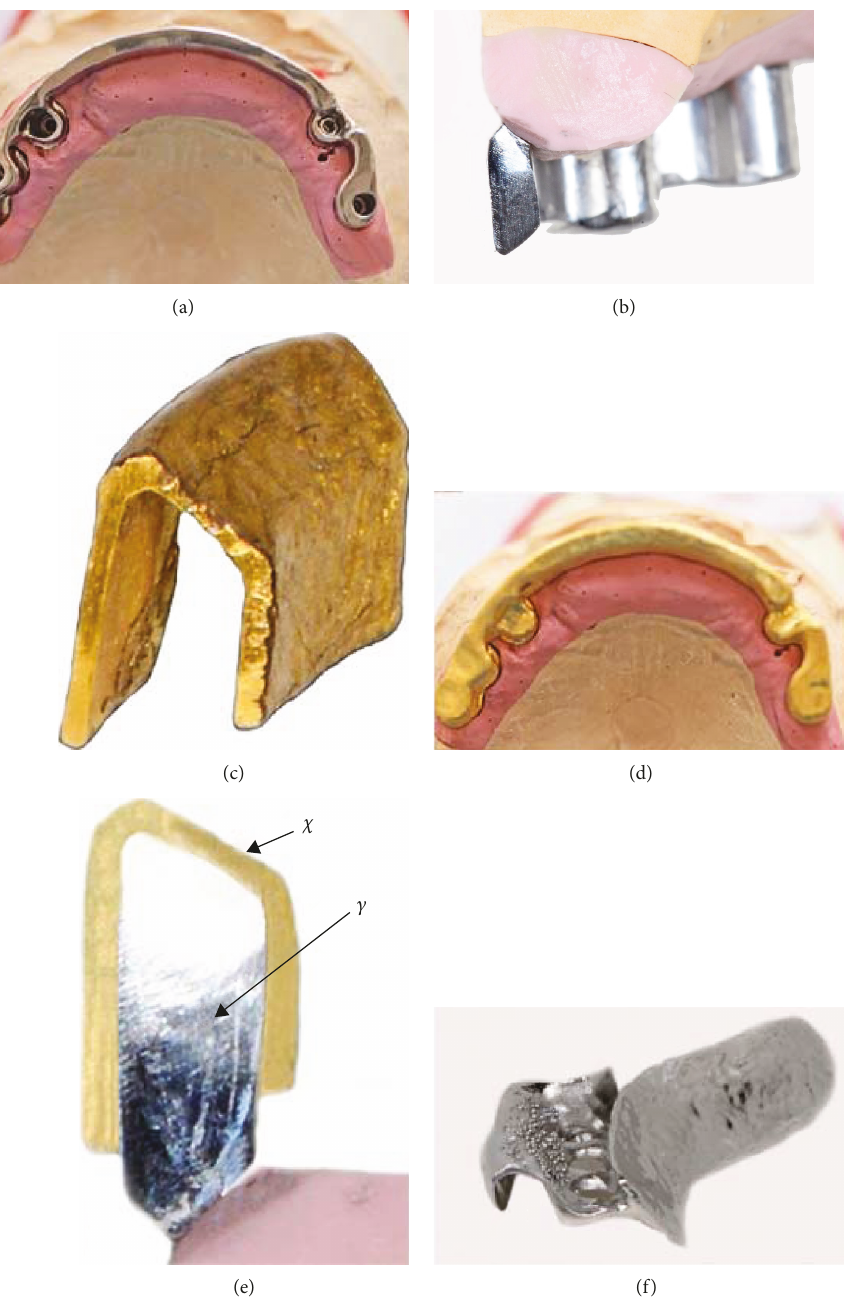
Figure 7: (a) The fabricated maxillary bar; (b) cross section of the bar on a model; (c) ELMES; (d) ELMES conforming to the shape of the bar; (e) cross section on a model demonstrating the use of the ELMES ( X ) over the bar ( Y ); (f) casted metal framework (laboratory work shown on a demonstration